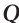
TABLE 3 | Network measures for the different networks.